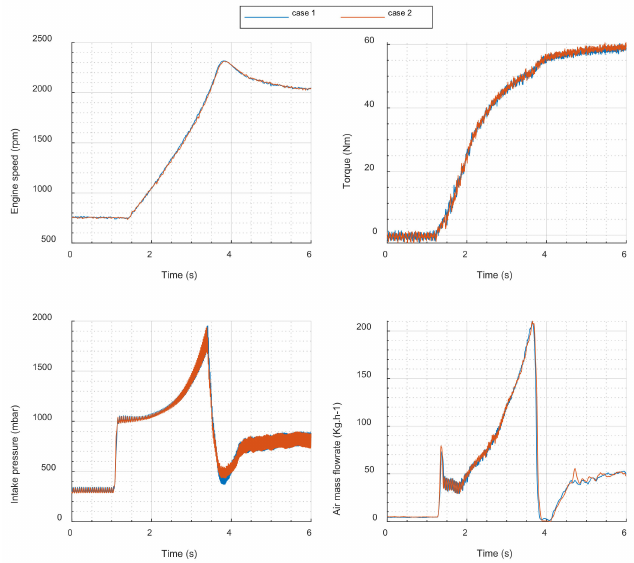
Figure 8. Evolution of engine parameters for cases 1 and 2.